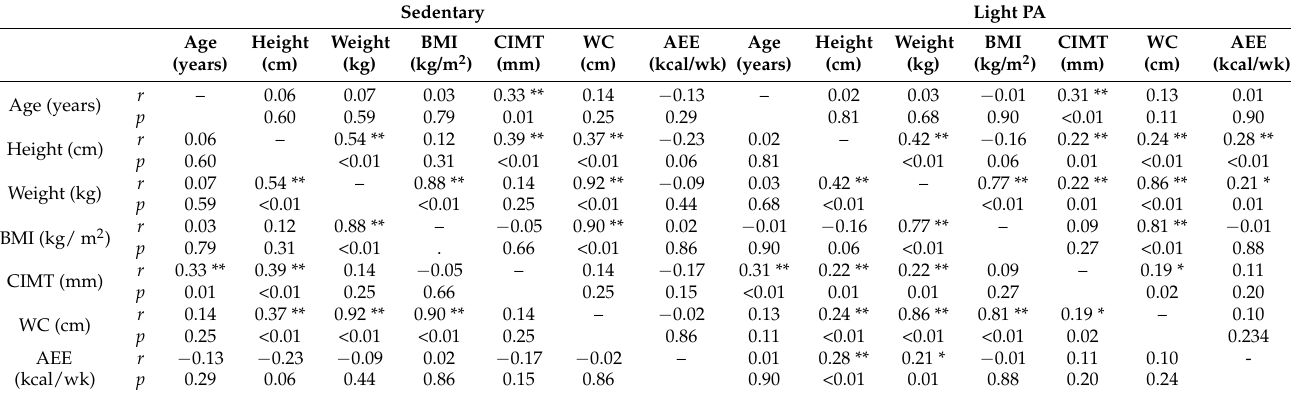
Table 4. Spearman’s rho correlation matrix for anthropometric measurements, activity energy expenditure, and carotid intima-media thickness among sedentary and light-intensity physical activity groups. Sedentary Light PA